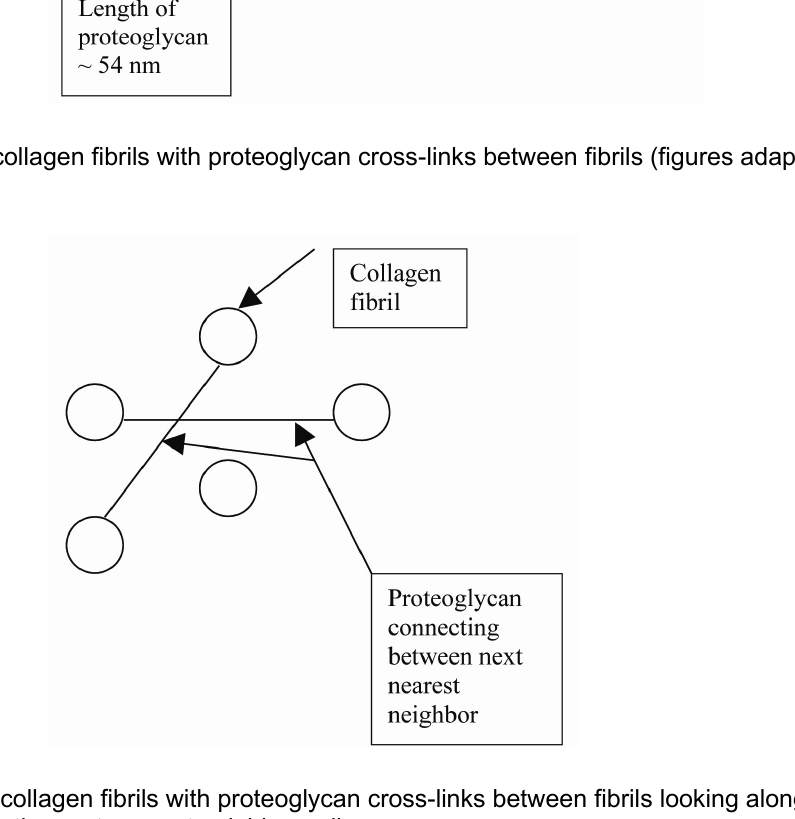
Figure 1b Schematic of collagen fibrils with proteoglycan cross-links between fibrils looking along the axis of the fibril. Each fibril is connected to the next nearest neighbor